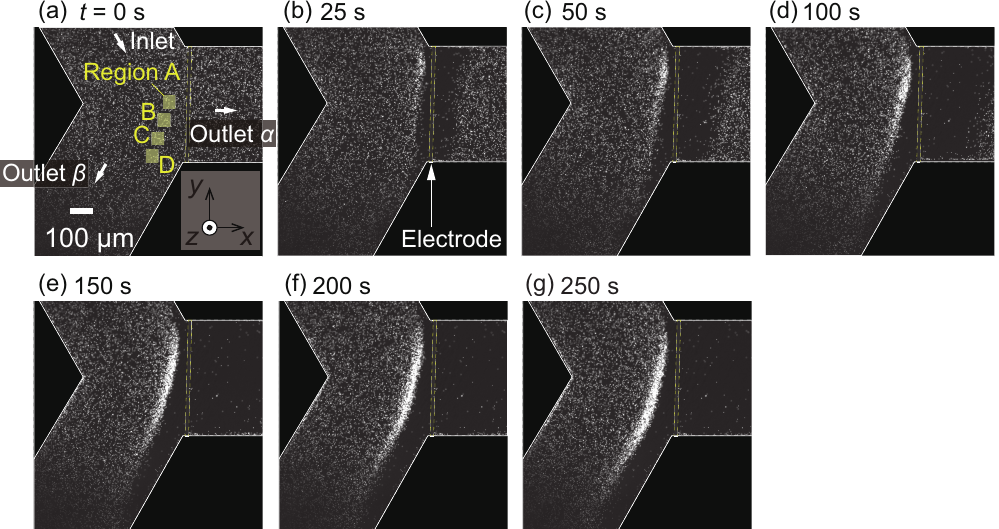
Figure 3. ( a – g ) Time series of the particle flow separation induced by microscale thermophoresis for the case with a particle diameter d = 1 µ m and ∆ P = 1.0 Pa. At t = 0 s, the heating by electrode is initiated. Particle flow from the inlet is separated at the Y-shaped branch. Because the thermophoresis is directed to the colder region, the PS particles cannot enter the outlet α